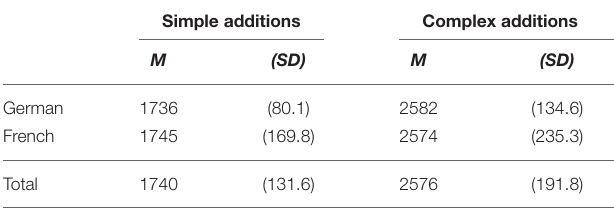
TABLE 1 | Mean duration of presentation of auditory additions in ms with standard deviation for each complexity level of the additions as a function of